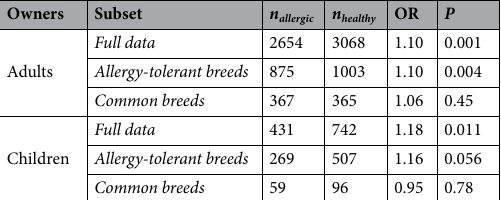
Table 4. Association between allergy and current living environment in owners. Adult and child owners were treated separately, using logistic regression. Only children whose average ages were over three years were considered. When current living environment becomes more urban, odds to become allergic are higher. Odds Ratio, OR =